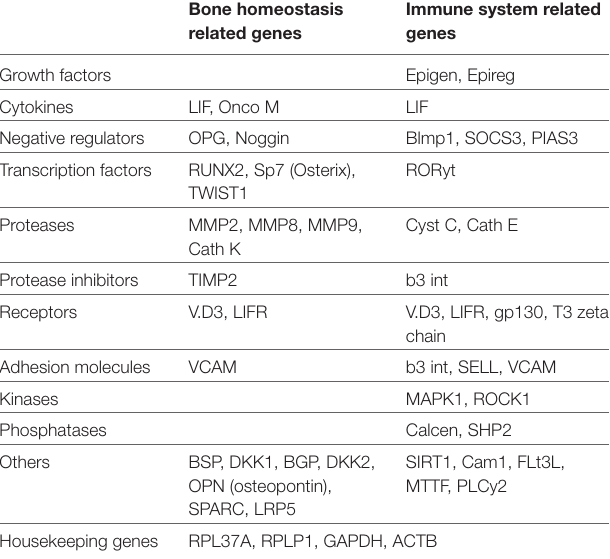
TaBle 2 | List of genes studied by PCR